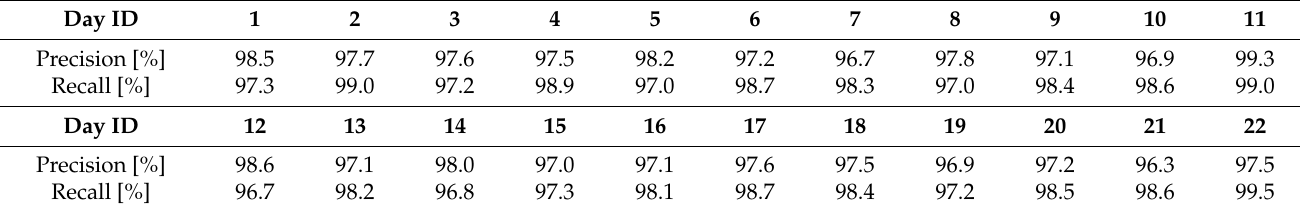
Table 2. Precision and Recall of area detection of WiMonitor over 22 days.